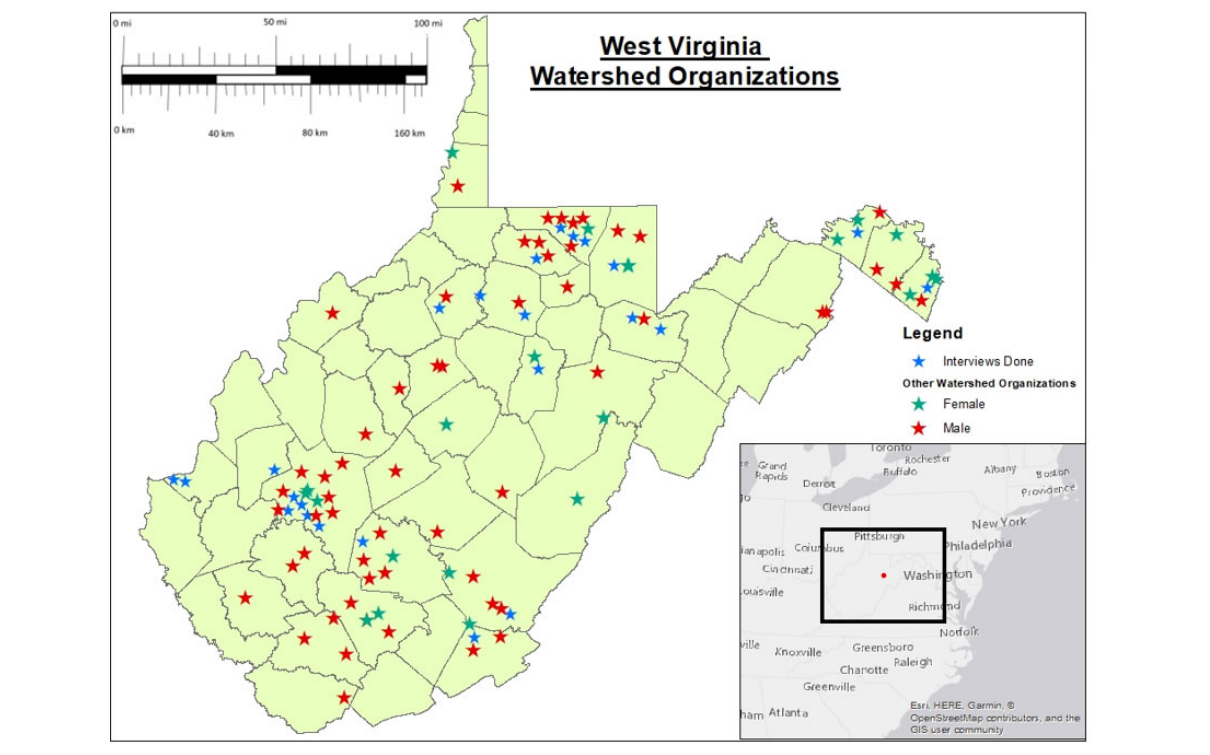
Fig. 1 . Geographical location of the 104 active water organizations in West Virginia, gender of their leadership, and location of interviewees’ organizations.